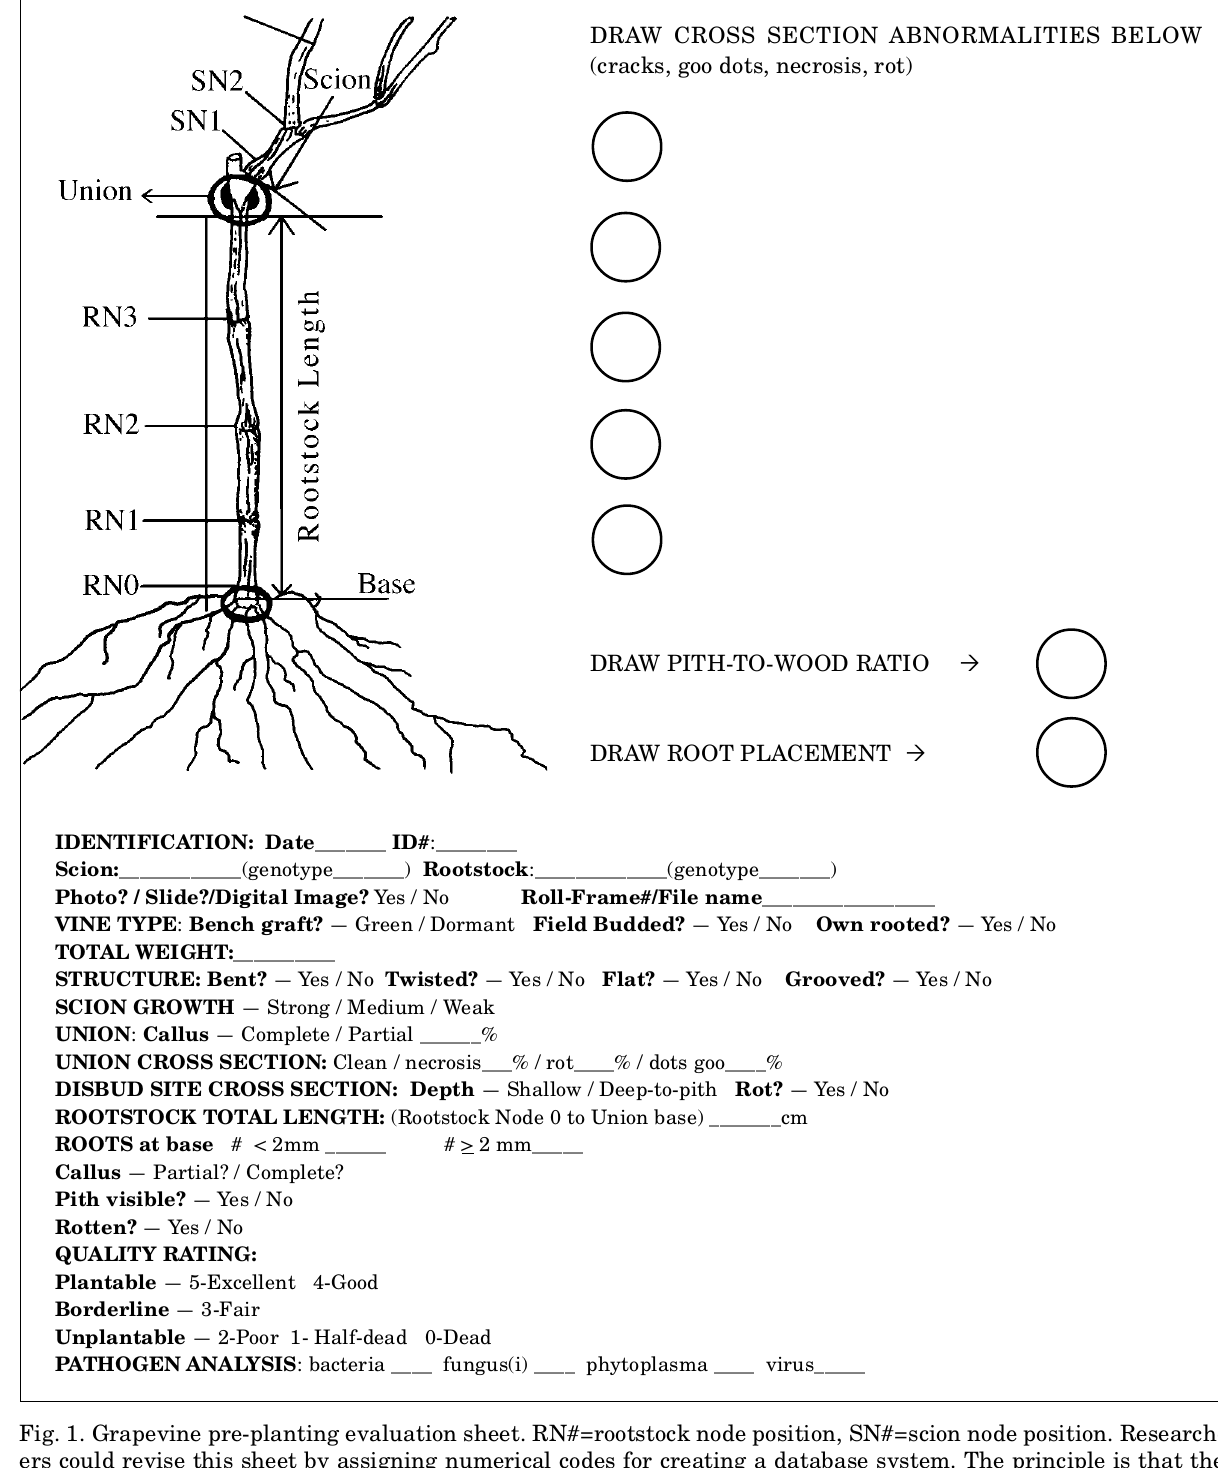
Fig. 1. Grapevine pre-planting evaluation sheet. RN#=rootstock node position, SN#=scion node position. Research- ers could revise this sheet by assigning numerical codes for creating a database system. The principle is that the condition of plant material used in experiments should be systematically evaluated